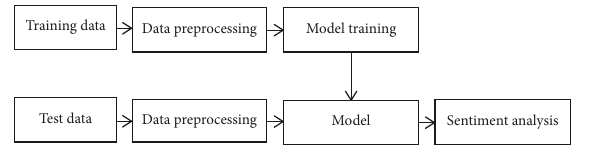
Figure 2: Text emotion analysis process based on machine